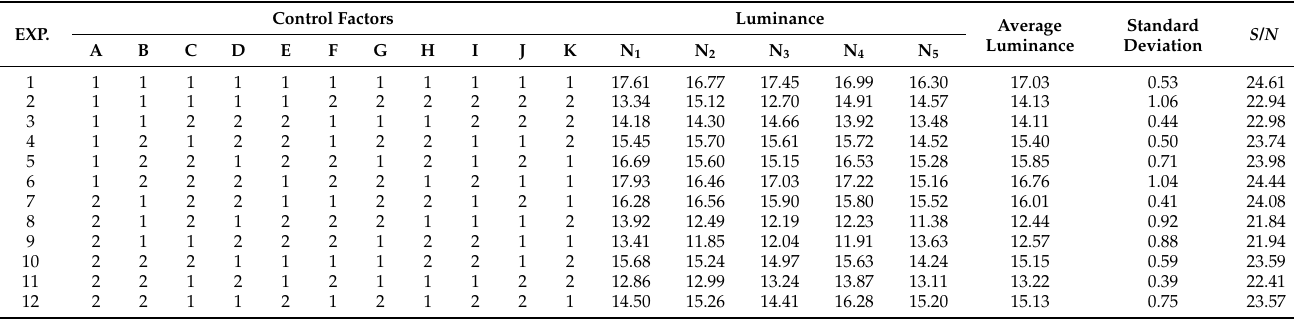
Table 3. L 12 (2 11 ) orthogonal array and data for the Taguchi method